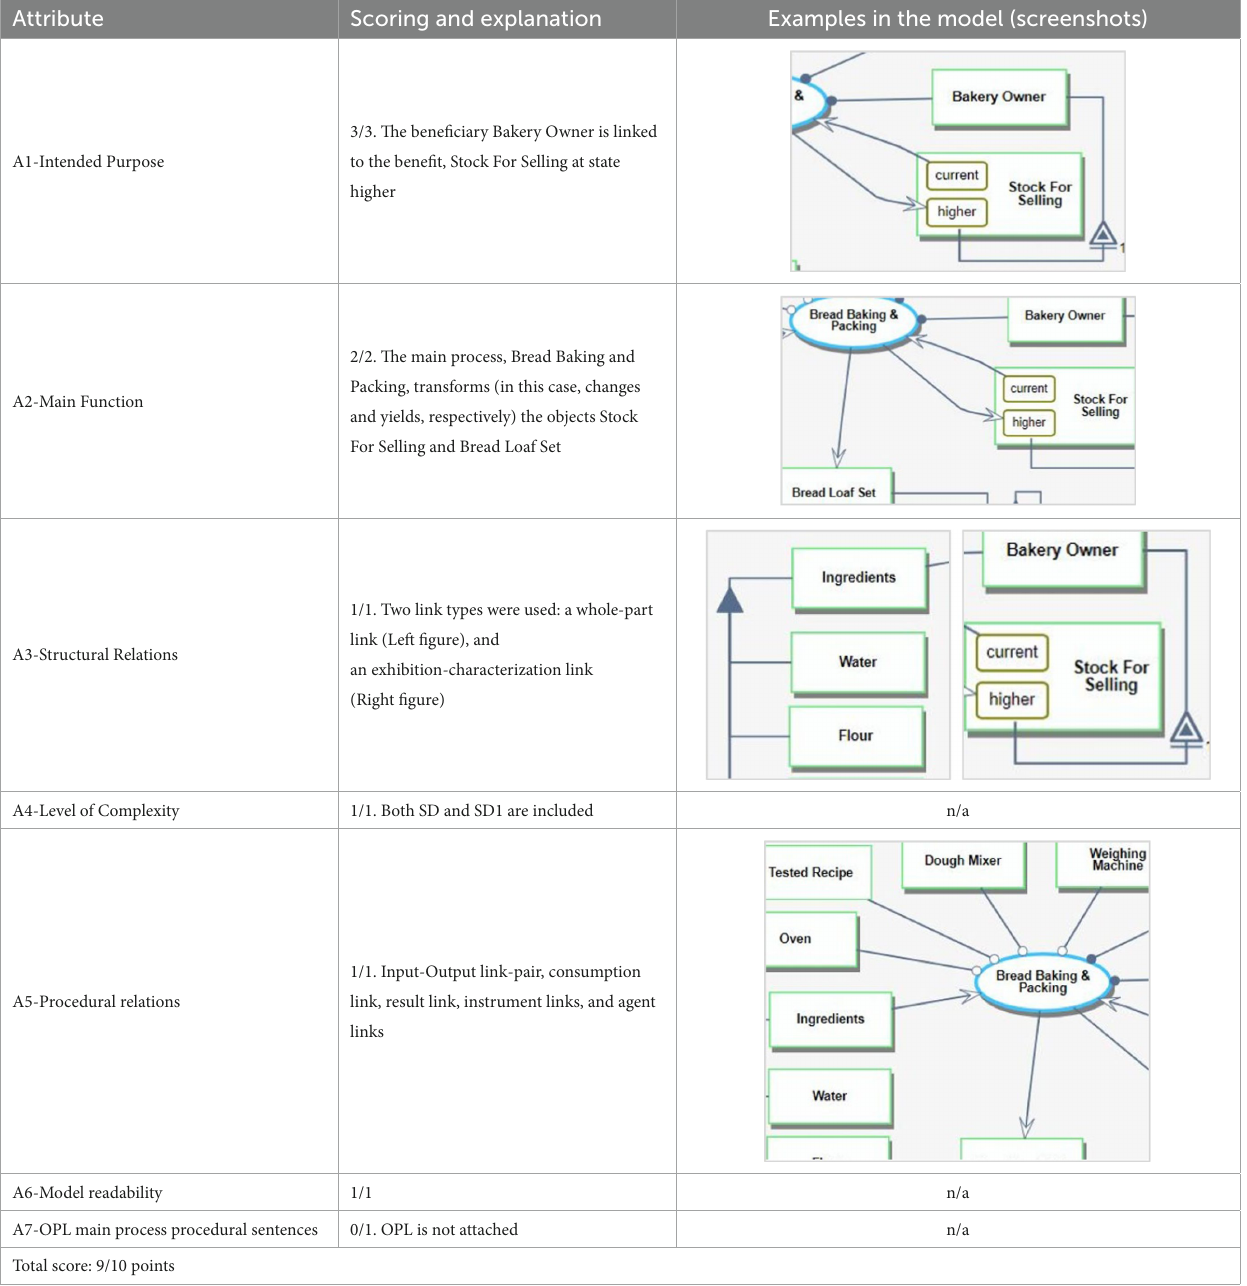
TABLE 9 Scores and explanations for the OPM model created by Romy. Attribute Scoring and explanation Examples in the model